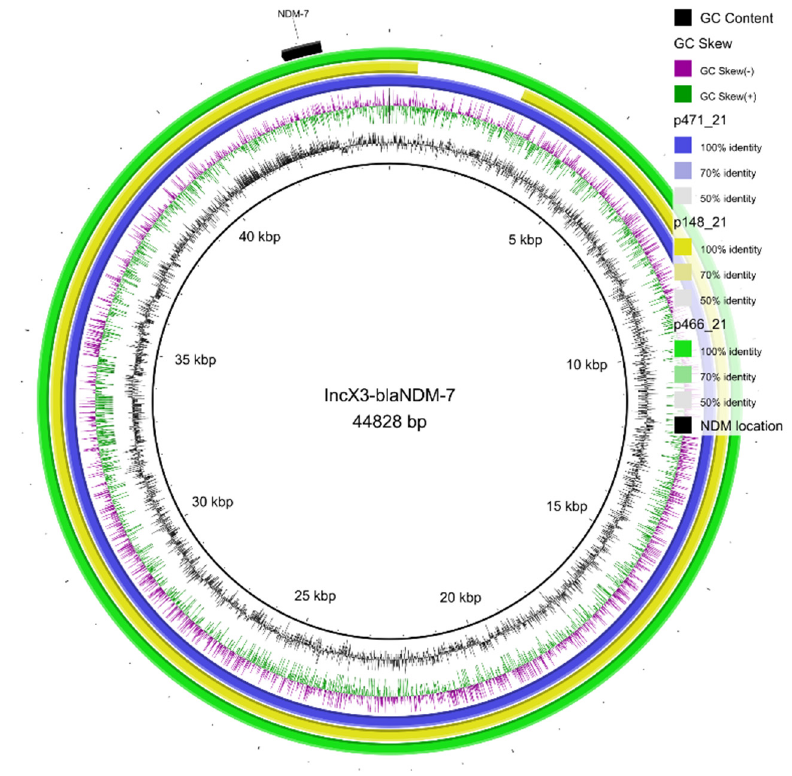
Figure 2. Schematic representation of the IncX3- bla NDM-7 plasmids identified in Klebsiella isolates 471_21 (blue), 148_21 (yellow), and 466_21 (green), highlighting the location of the bla NDM-7 gene (in black). The figure was generated on BRIG software using p471_21 as a reference.